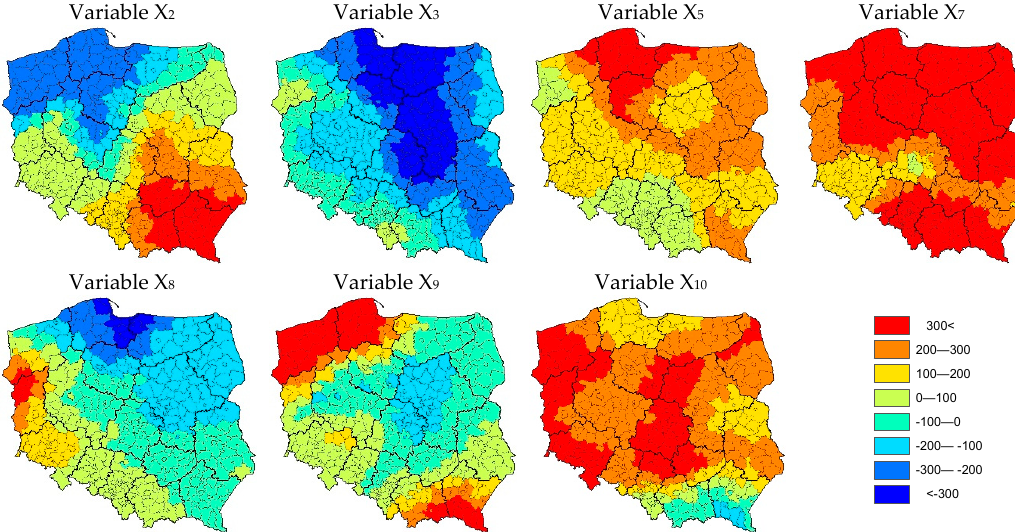
Figure 3. Spatial distribution of the parameters at local variables in the MGWR1 model (standardised variable values were used for estimation). Source: own research.